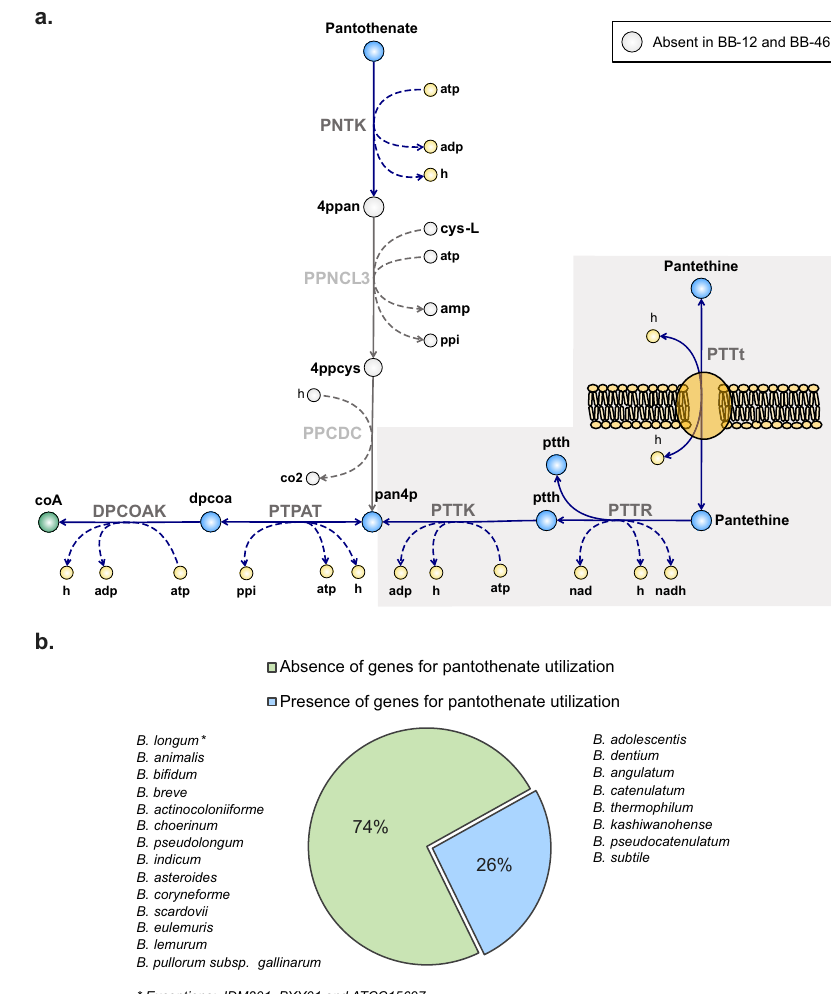
Fig. 4 Coenzyme A biosynthesis in bi fi dobacteria. a Proposed pathway of coenzyme A (coA) biosynthesis in BB-12 and BB-46 from pantethine via pantetheine (ptth): Genes for phosphopantothenate-cysteine ligase (EC 6.3.2.5) and phosphopantothenyl cysteine decarboxylase (EC 4.1.1.36), catalyzing the conversion of phosphopantothenate (4ppan) into pantethine-4-phosphate (pan4p) through the PPNCL3 and PPCDC reactions, are absent in BB-12 and BB-46. Reactions highlighted by the gray background have been added to i AZ480 and i MS520 based on experimental evidence for pantethine utilization by BB-12 and BB-46. Added reactions include a pantethine-proton symporter (PTTt, no gene association), a pantethine reductase (PTTR, no gene association), and a pantetheine kinase (PTTK). Abbreviations of metabolite and reaction names are the same as used in the models (Supplementary Data 3 and 4). b Presence/absence of genes for pantothenate utilization in different Bi fi dobacterium species, based on data from publicly available genome sequences in the KEGG essential nutrients missing in the medium (Fig. 3a). The experi- mental results con fi rmed the absolute requirement of BB-12 for nicotinic acid and a lack of effect on growth of the removal of nicotinamide from the medium (Fig. 3b). Based on the KEGG database, the absence of a gene for nicotinamidase (EC 3.5.1.19) is a shared characteristic among all sequenced B. animalis strains, whereas all sequenced B. longum strains possess the gene. Vitamin B 9 : Tetrahydrofolate (THF), the active form of folate (vitamin B 9 ), is an essential cofactor for nucleic acid synthesis. The ability of Bi fi dobacterium strains to produce folate was previously reported to be strain-dependent 51 – 53 and in some strains promoted by the supply of para -aminobenzoic acid 54 . In bacterial folate biosynthesis, para -aminobenzoic acid is required for the formation of dihydropteroate in the dihydropteroate synthase (EC 2.5.1.15) catalyzed reaction (DHPS2; Fig. 5b). i MS520 predicted a requirement of BB-46 for para -aminobenzoic acid in the absence of